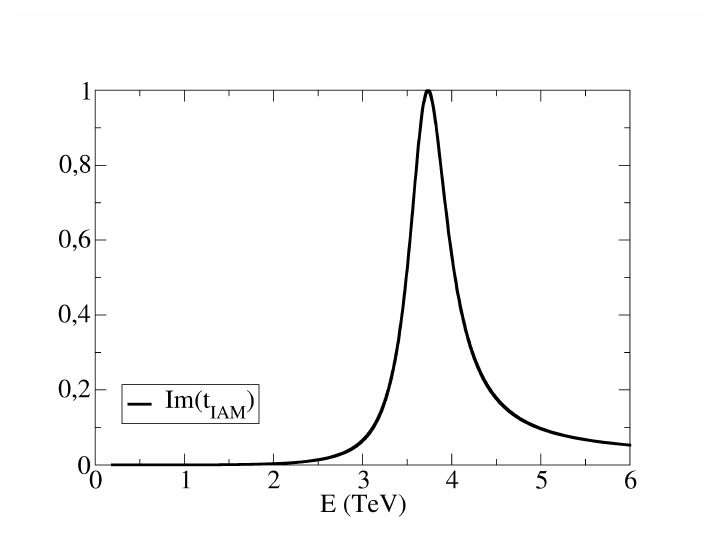
W scattering in the HEFT formula- L L